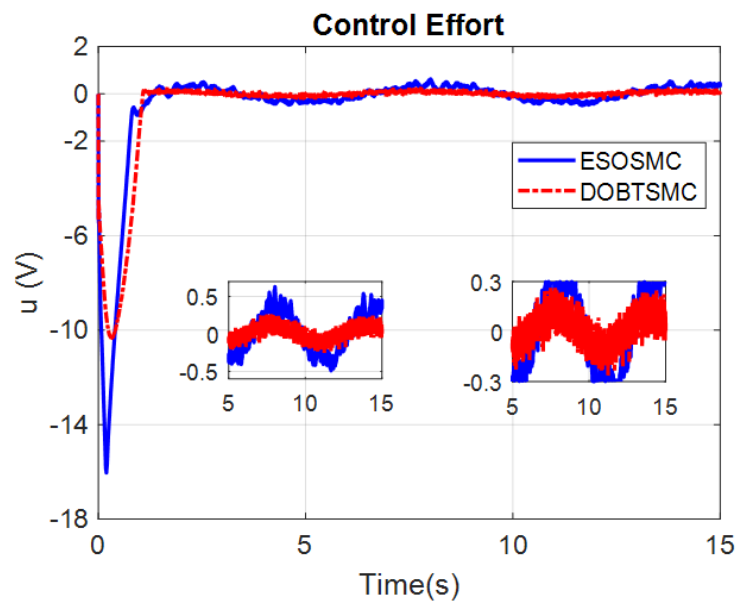
Figure 11. Control signal trajectory of ESOSMC and DOBTSMC.